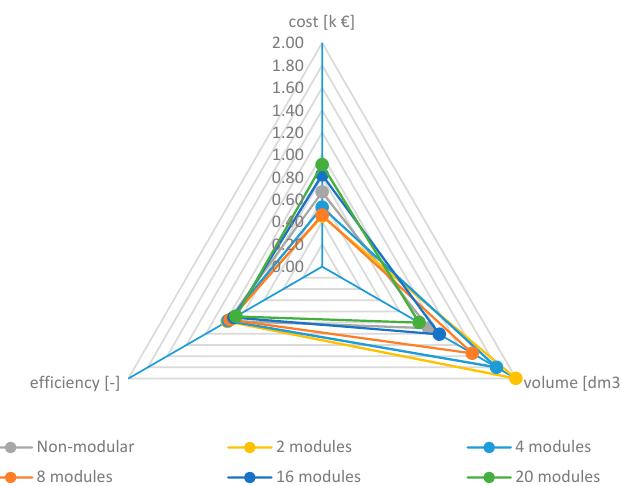
Figure 8. Comparison of qualitative parameters for the non-modular and modular concept for 100 kHz of switching frequency.